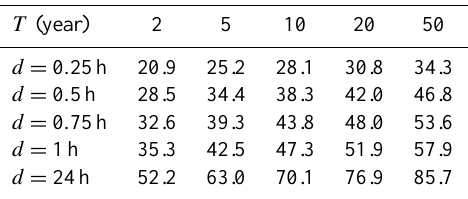
Table 4. Rainfall depths (mm) for return periods T (year), and ag- gregation times d (h) based on the adjusted IDF-curves of A-data at the station Karama-Plateau (Rwanda).